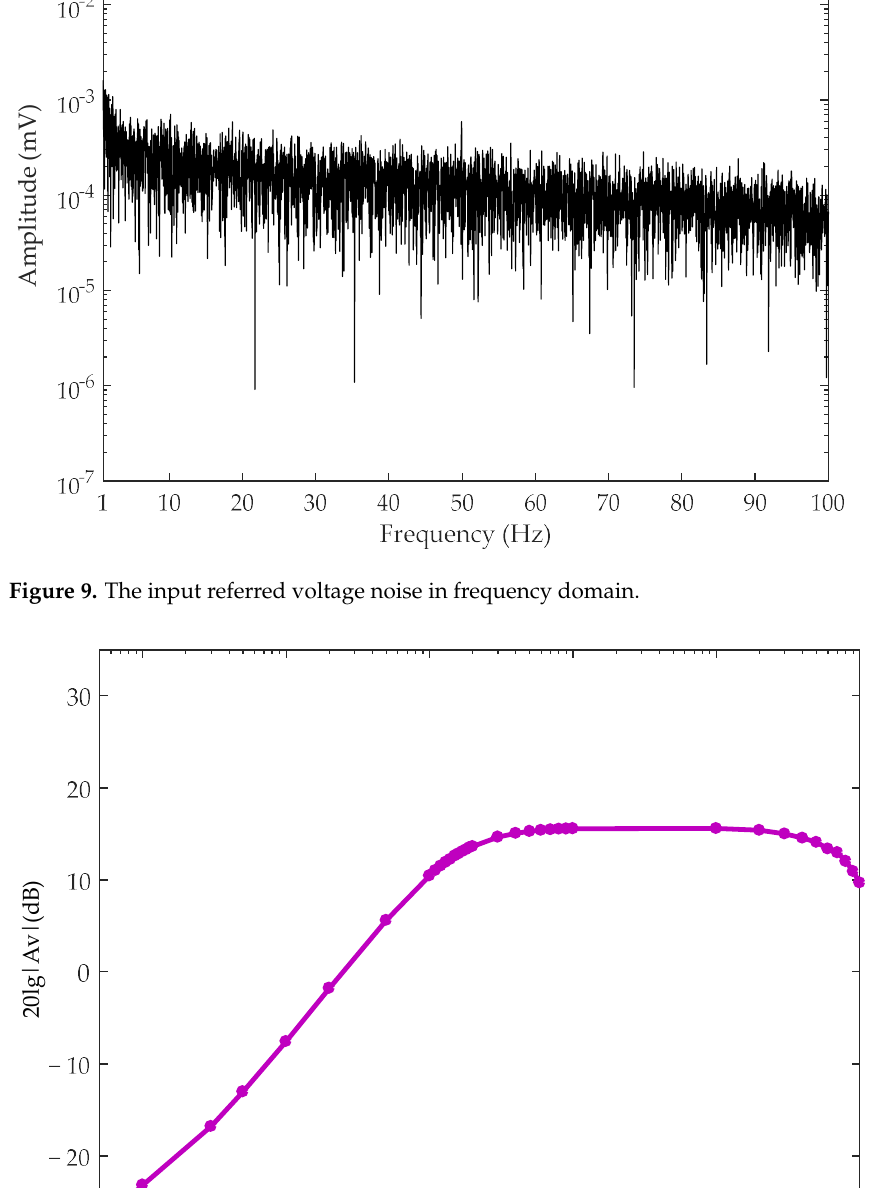
Figure 8. The detection circuit of the infrared system.